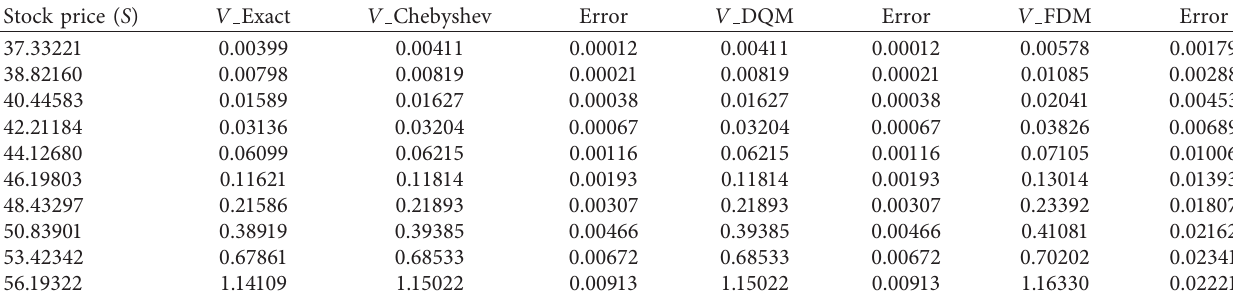
Table 3: The absolute error of Chebyshev spectral scheme, differential quadrature scheme, and FDM at t � 0. Stock price ( S